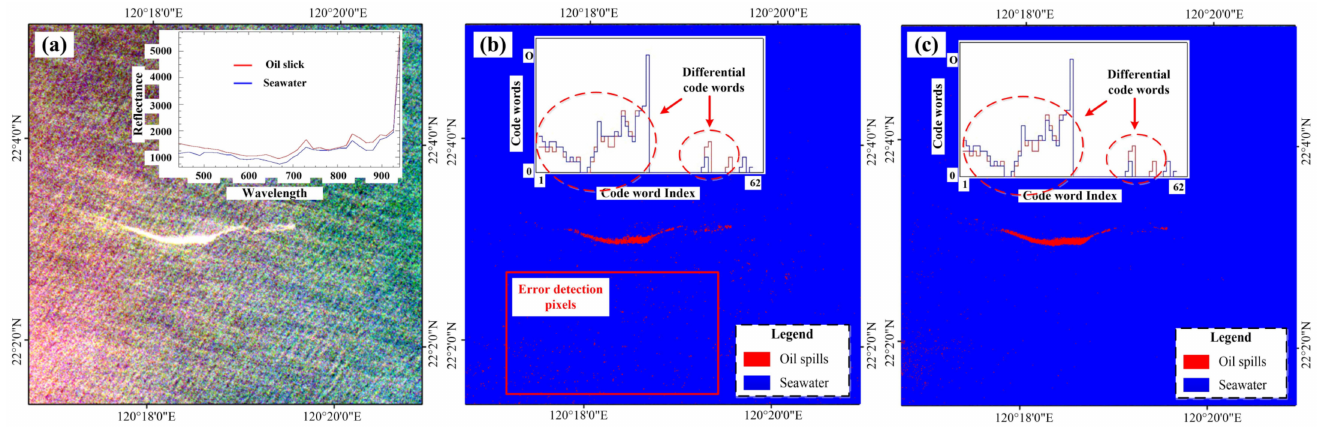
Figure 9. The experimental data 5 (( a ), captured by the Zhuhai-1 satellite) and its natural seepage detection results produced by the MSE method with SSI ( b , c ). Differential code words could be observed in the red